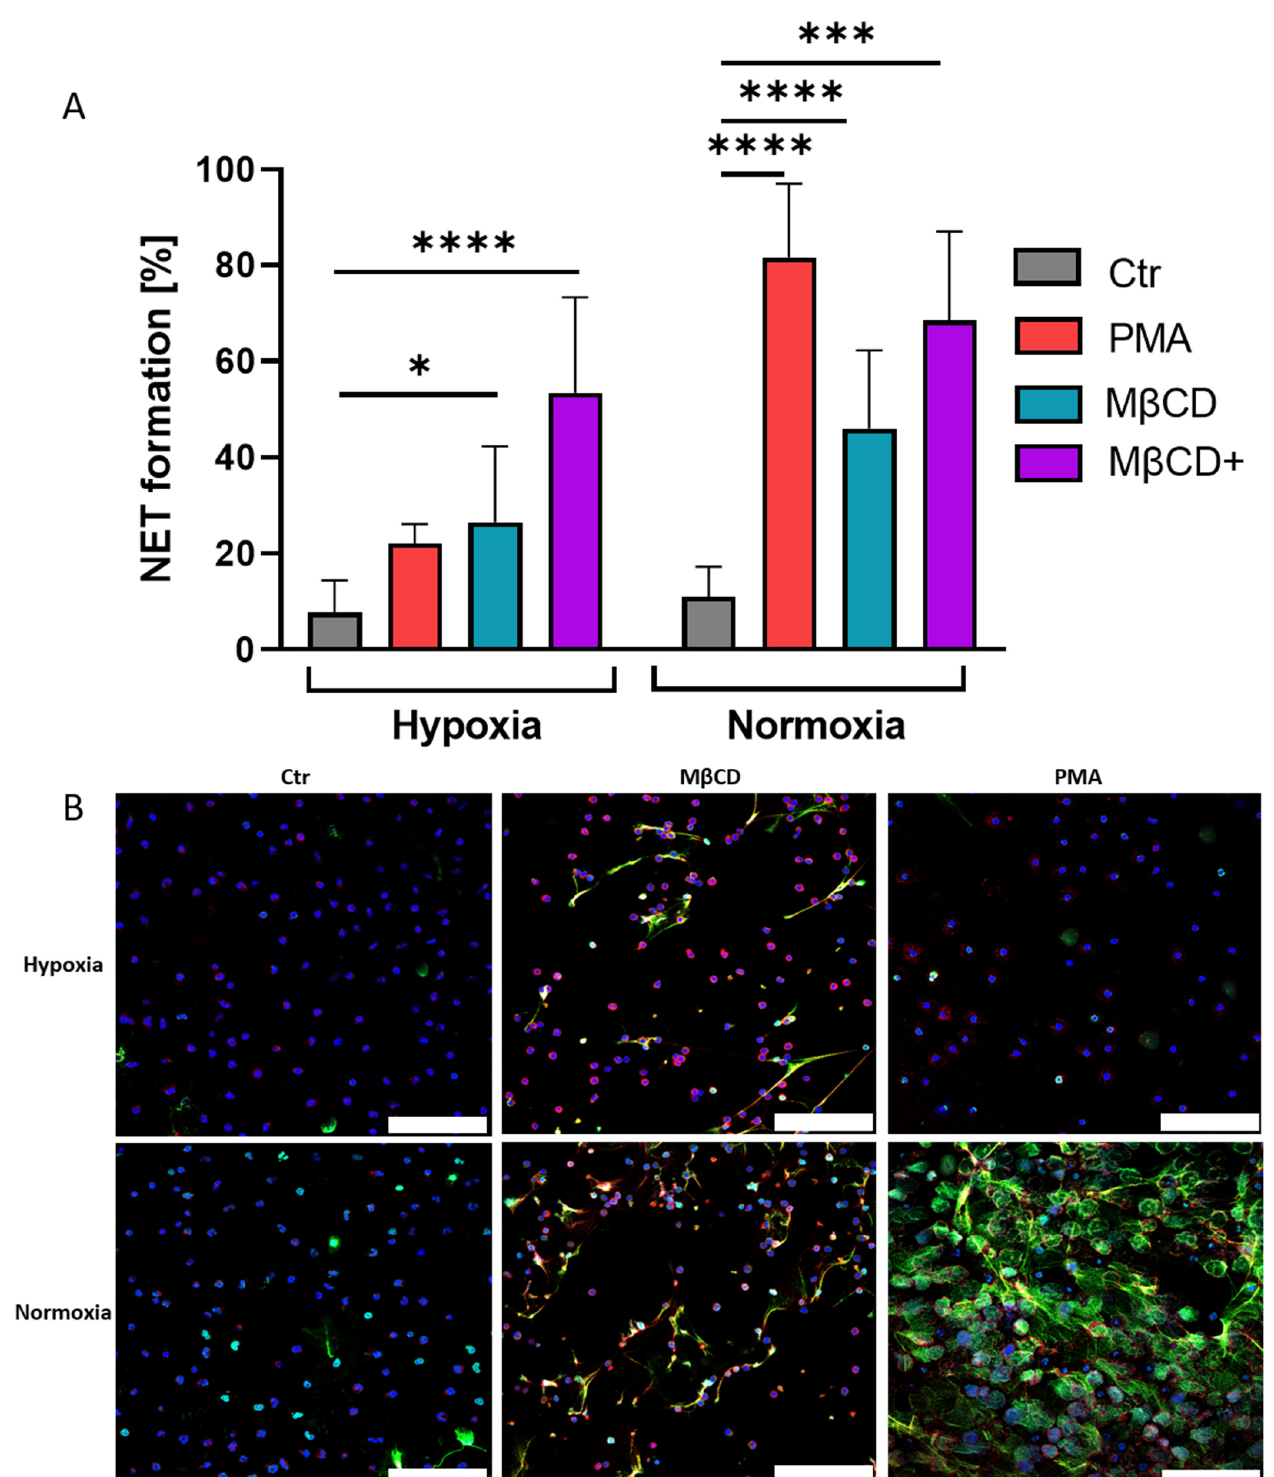
Figure 3. ( A ): Human neutrophils incubated under hypoxia and normoxia after stimulation with either PMA, M β CD, or M β CD+. NET formation by PMA was inhibited under hypoxia, M β CD+ stimulation resulted in NET formation under hypoxia and normoxia. Significance was analyzed via 1-way ANOVA with multiple comparisons. ( B ): Representative immune fluorescence images. The upper row shows NET formation with respective stimulus under hypoxia, bottom row for normoxia. Blue: DAPI, green: DNA/Histone1 complexes, red: myeloperoxidase (MPO). Scale bars: 100 µ m. N = 4, (=3 for M β CD+). (* p < 0.05, *** p < 0.001, **** p <